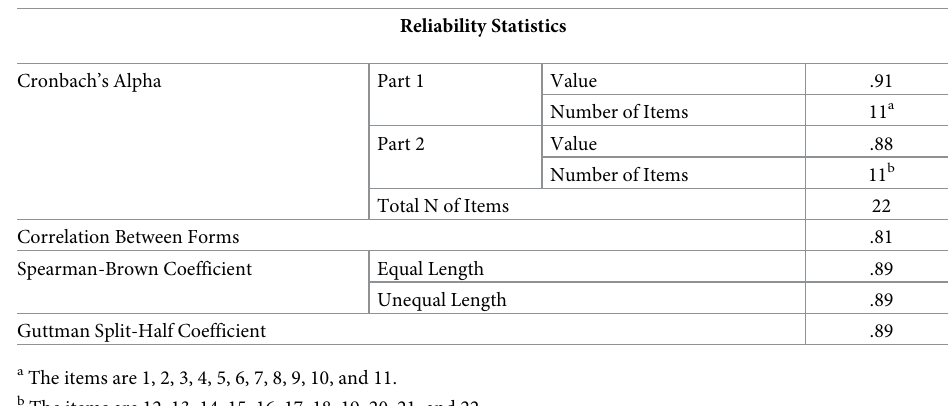
Table 5. Reliability